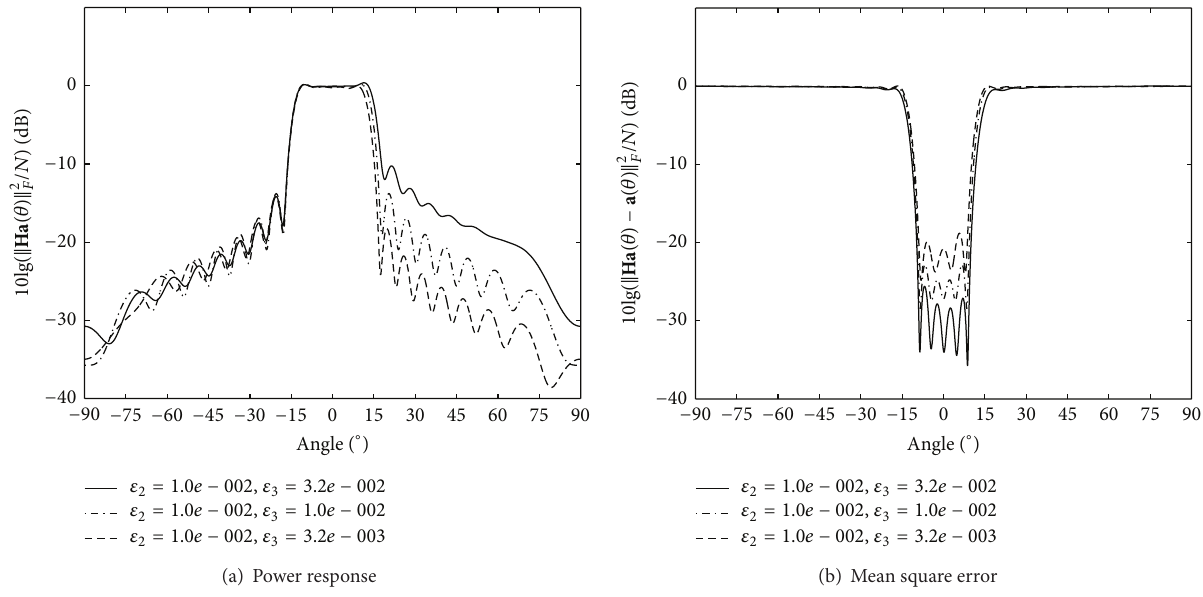
Figure 5: Characteristics of the spatial matrix filters designed by DM4.